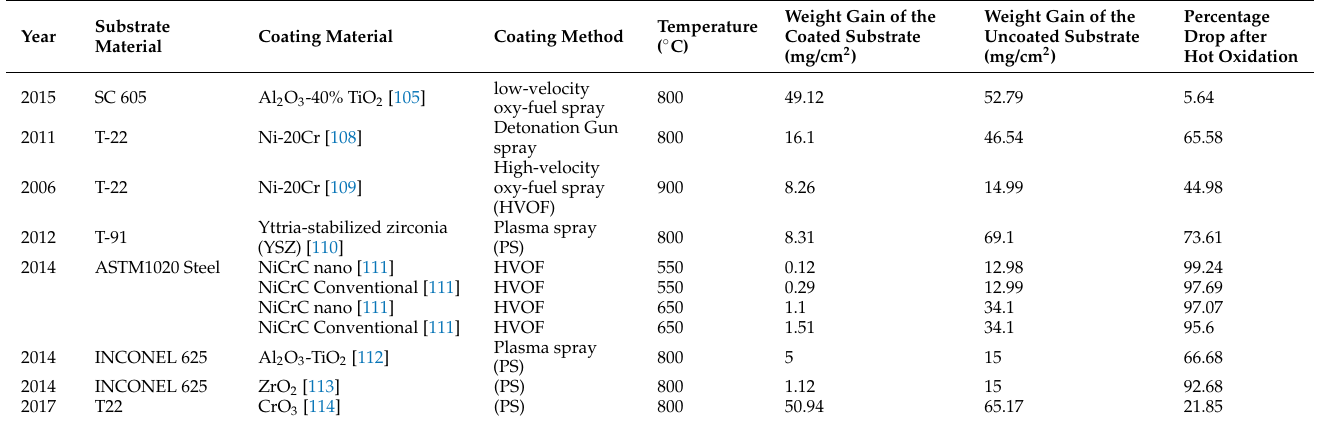
Table 3. Thermal oxidation performance obtained from different coating